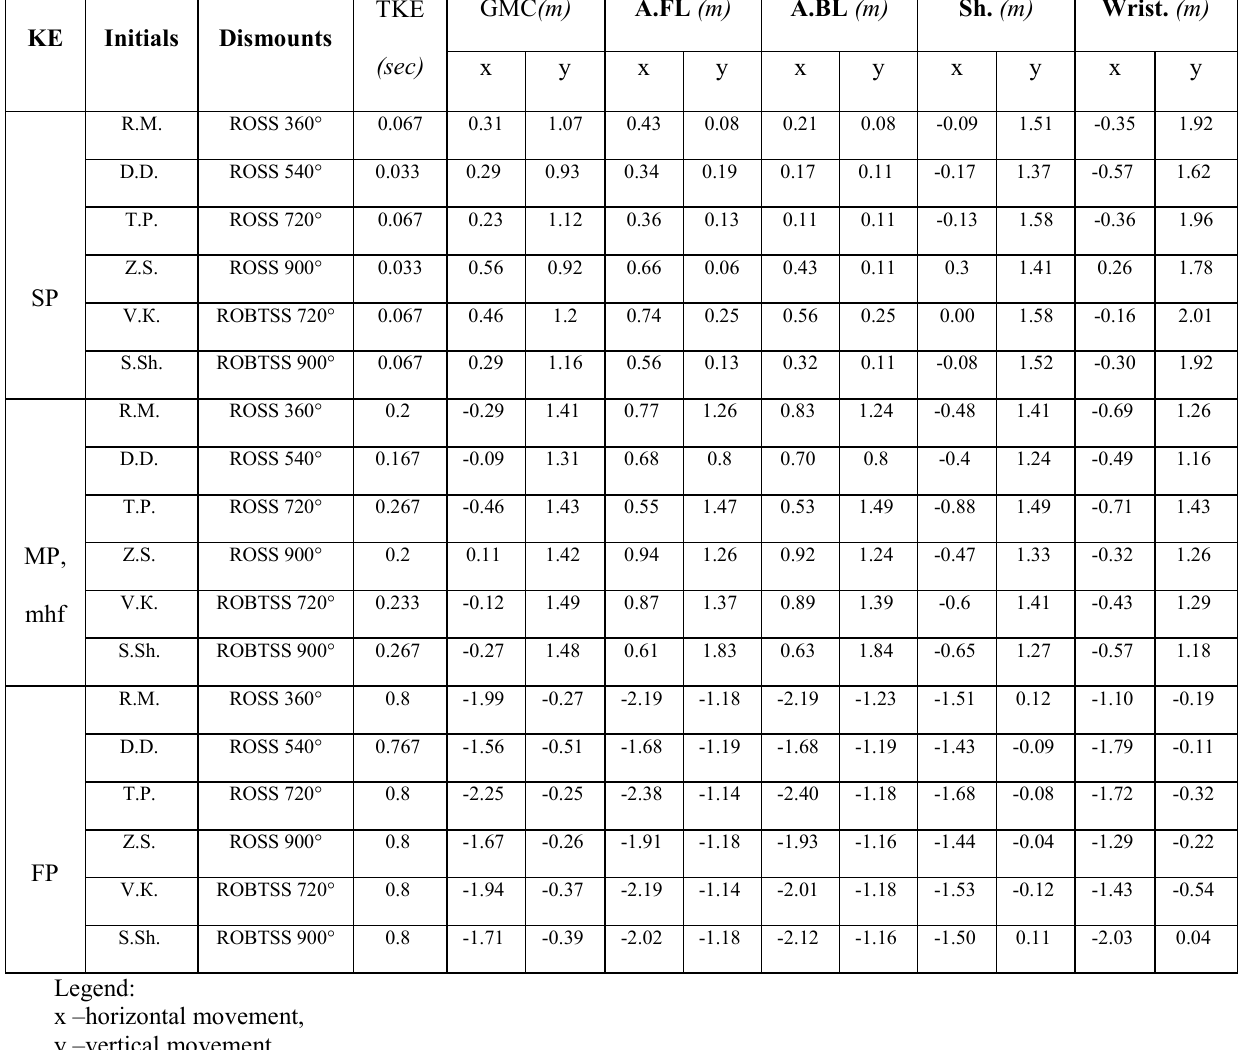
Comparative indicators of space-time characteristics of key elements of dismounts from BB of types: somersault from RO and RO- backward turnover by data of joints’ trajectories of junior, 12-14 years old female gymnasts (n =